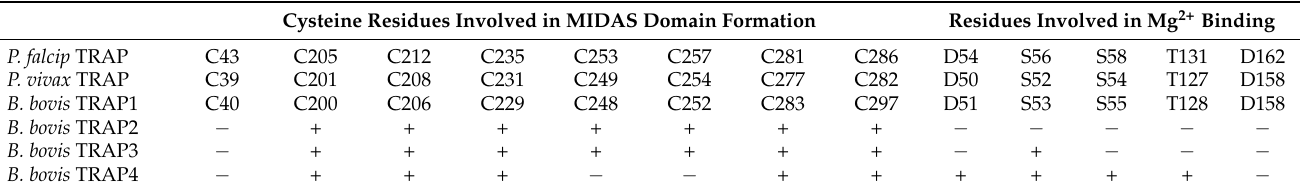
Table 4. Conservation of residues of significance in Plasmodium sp. TRAP and B. bovis TRAP1 orthologs, with comparison to other B. bovis TRAP